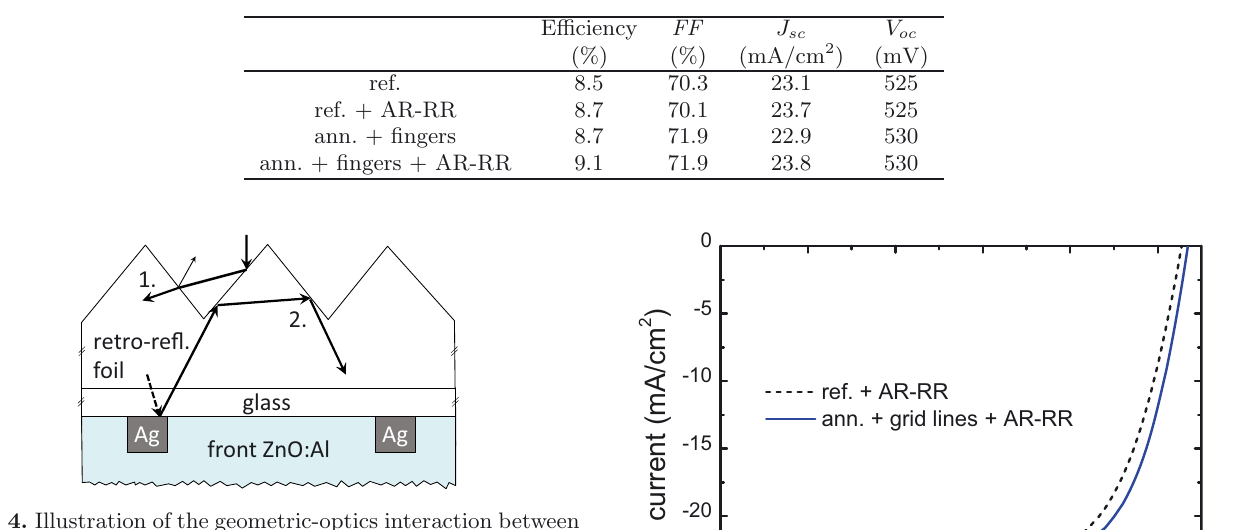
Table 1. J - V parameters of cells (average of the three best), with and without an AR-RR foil, deposited on a reference ZnO:Al layer (ref.) and on a ZnO:Al layer annealed at 600 ◦ C for 3.5 h (ann.) fitted with Ag fingers.